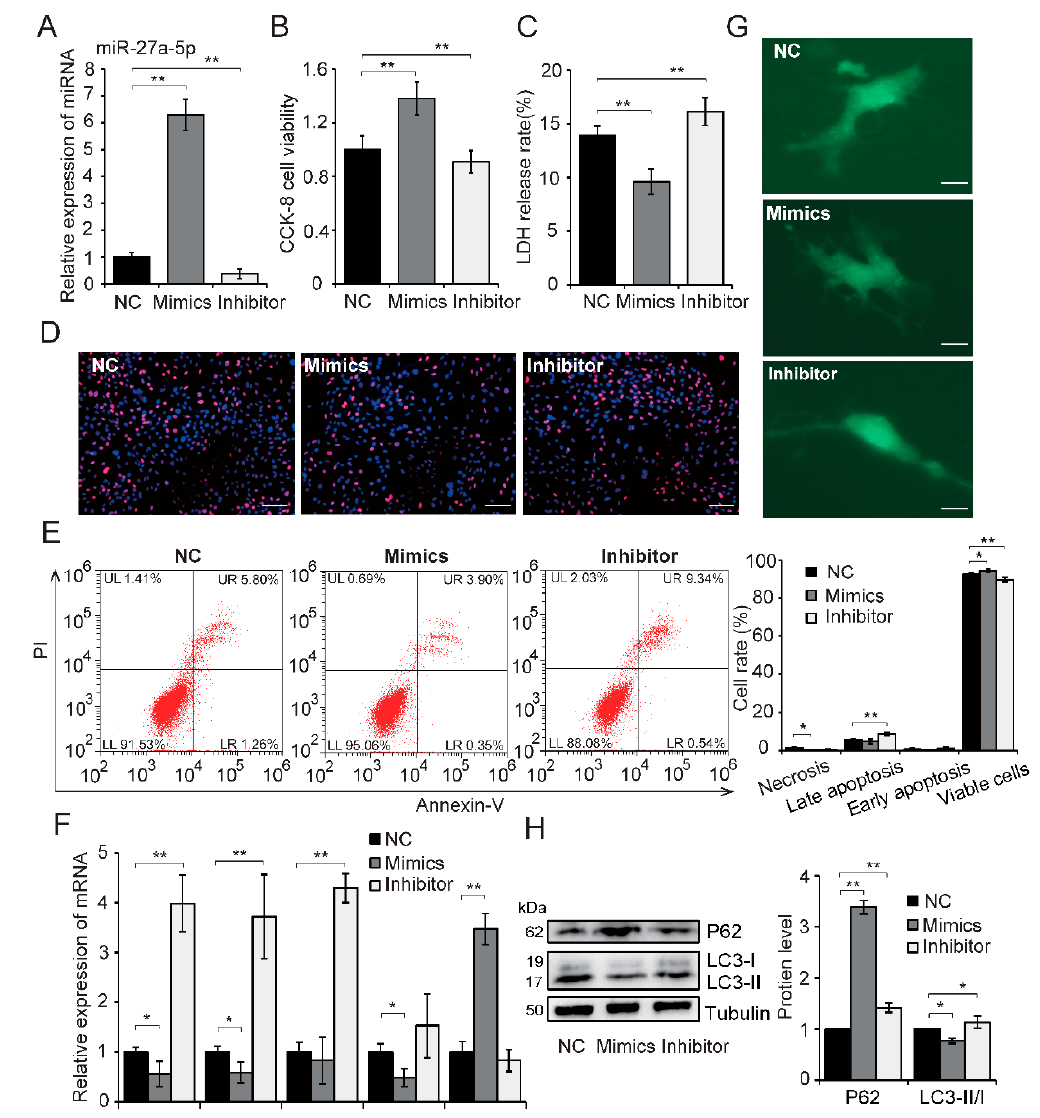
Figure 4. miR-27a-5p attenuates hypoxia-induced excessive autophagy and apoptosis in H9c2 cells. H9c2 cells were exposed to hypoxia for 24 h after transfection of a specific miR-27a -5p mimics or inhibitor. Transfection efficiency was analyzed by qRT-PCR ( A ). Cell viability ( B ), membrane damage ( C ), and cell apoptosis ( D – F ) were assessed by CCK8 assays, LDH release assays, apoptosis staining (scale bar: 50 µ m), flow cytometry and qRT-PCR analysis, respectively. The level of autophagy was evaluated by GFP-LC3 fluorescence after hypoxia for 24 h ( G ); scale bar: 5 µ m. Autophagy-related proteins were detected by western blot ( H ). Three independent experiments were performed in triplicate. Data are expressed as the mean ± SD. * p < 0.05, ** p < 0.01. NC: negative control.